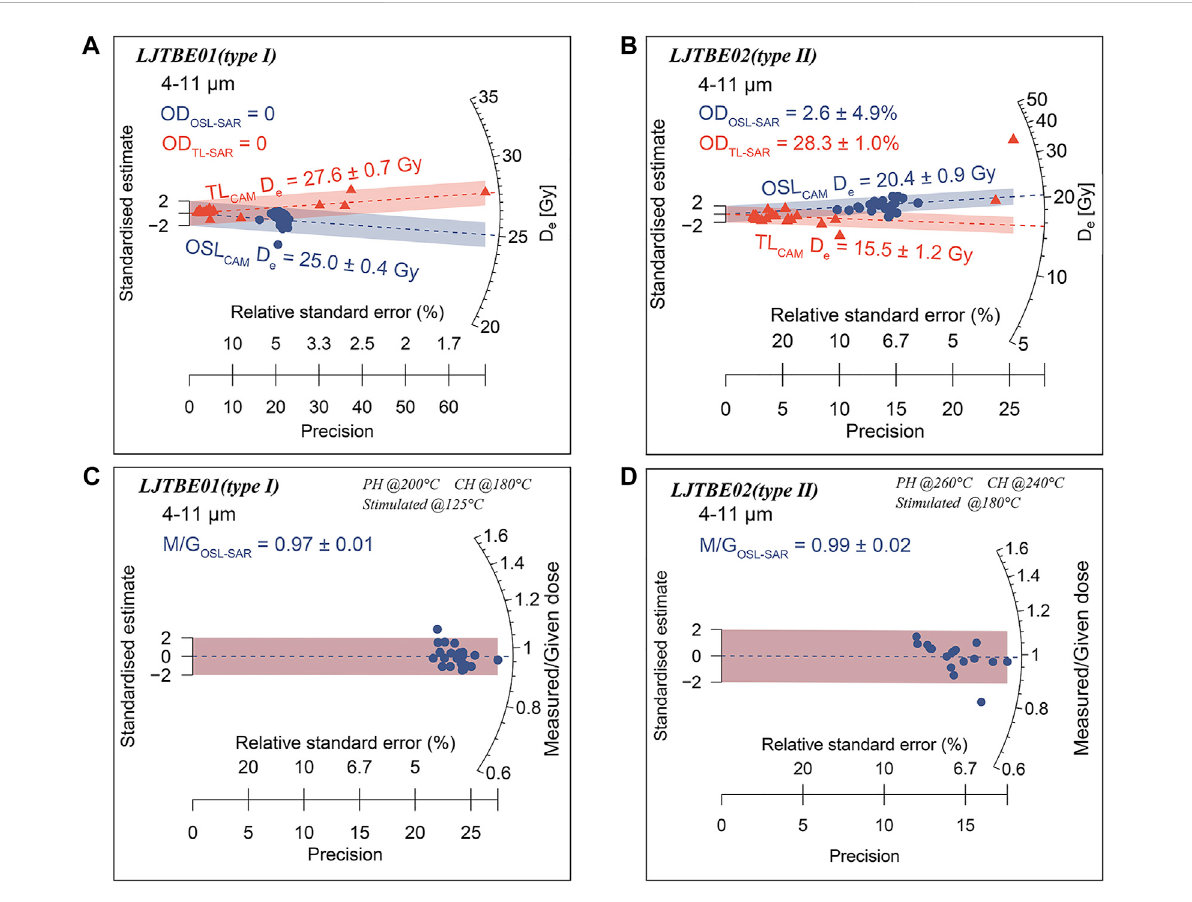
FIGURE 6 (A) Radial plot showing the D e distribution of a typical Type I sample ( LJTBE01 ). The blue circles indicate the D e values for OSL-SAR dating procedures, and the red triangles indicate those for TL-SAR. (B) Similar to (A) , this plot shows the radial plot of the representative type II